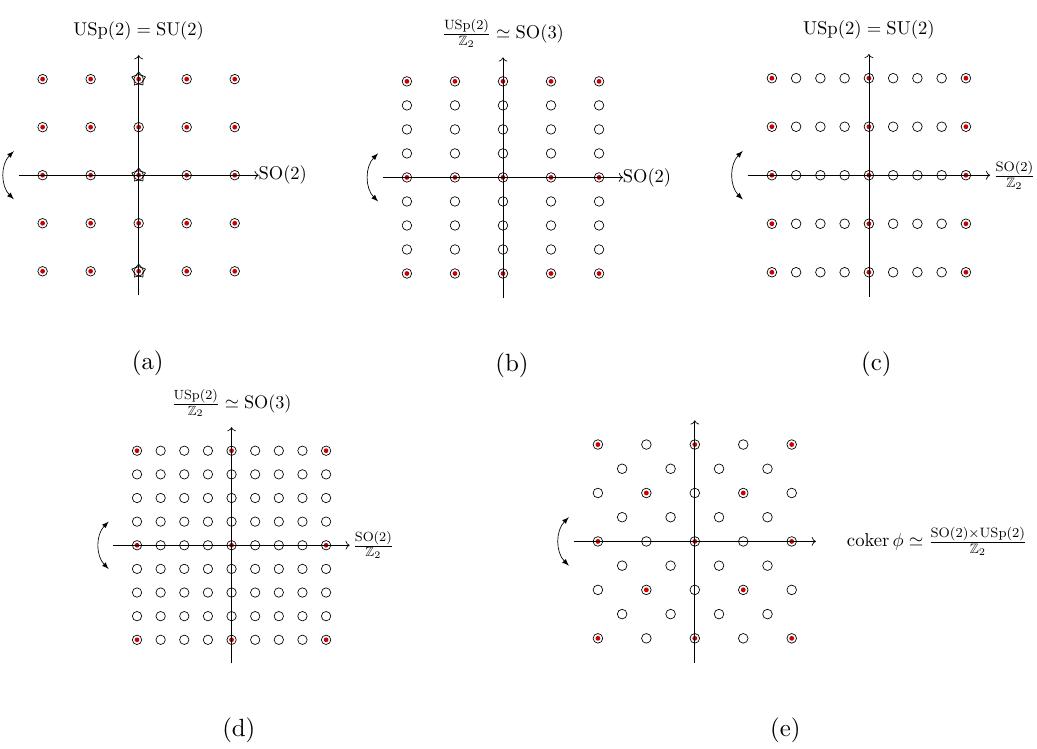
Figure 1. In all the diagrams, the red dots show the weight lattice, and the black circles show the dual lattice, which is the magnetic lattice involved in the monopole formula. The arrow denotes the action of the Weyl group. a: the stars show the root lattice of USp(2) . This notion does not extend to the full group SO(2) × USp(2) because of the Abelian factor. We do not show the roots on the other diagrams. b: USp(2) is replaced by SO(3) . c: SO(2) is replaced by SO(2) / Z 2 ’ SO(2) , which rescales the weights. d: combinations of the two Z 2 modifications of b and c. The weight